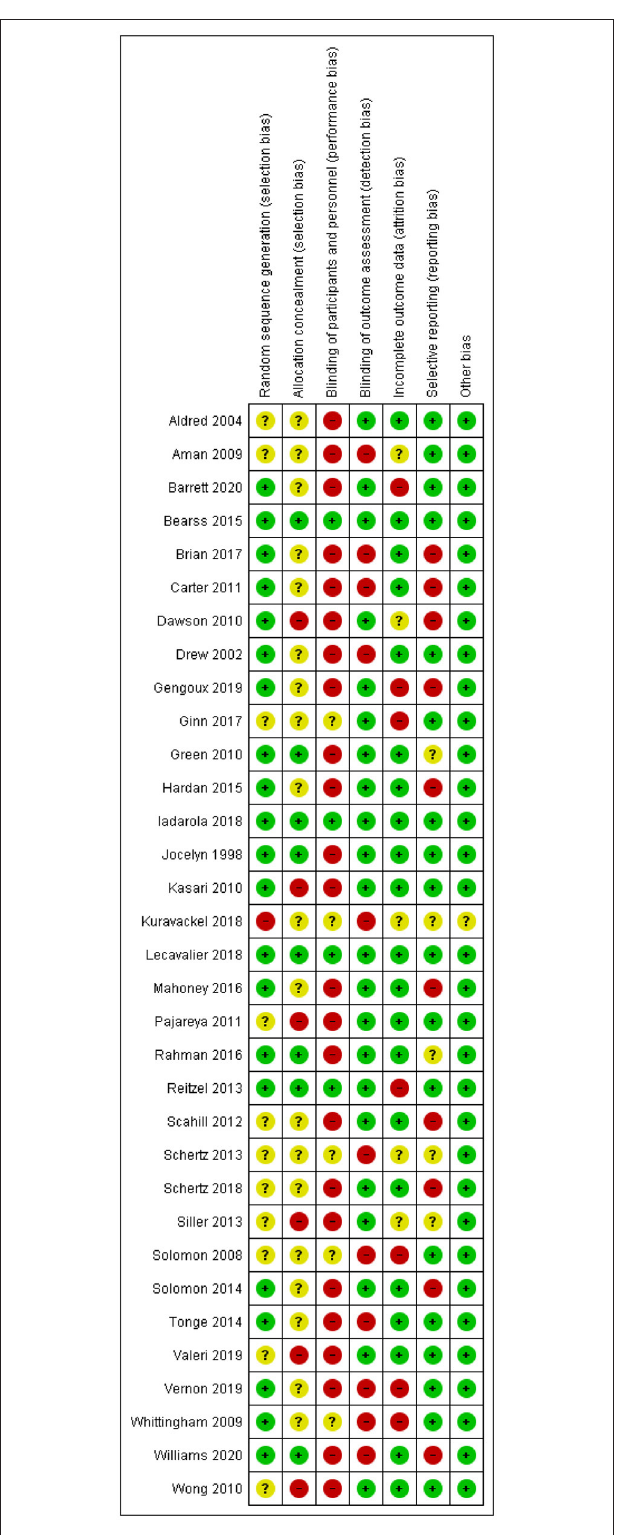
FIGURE 3 | Risk of